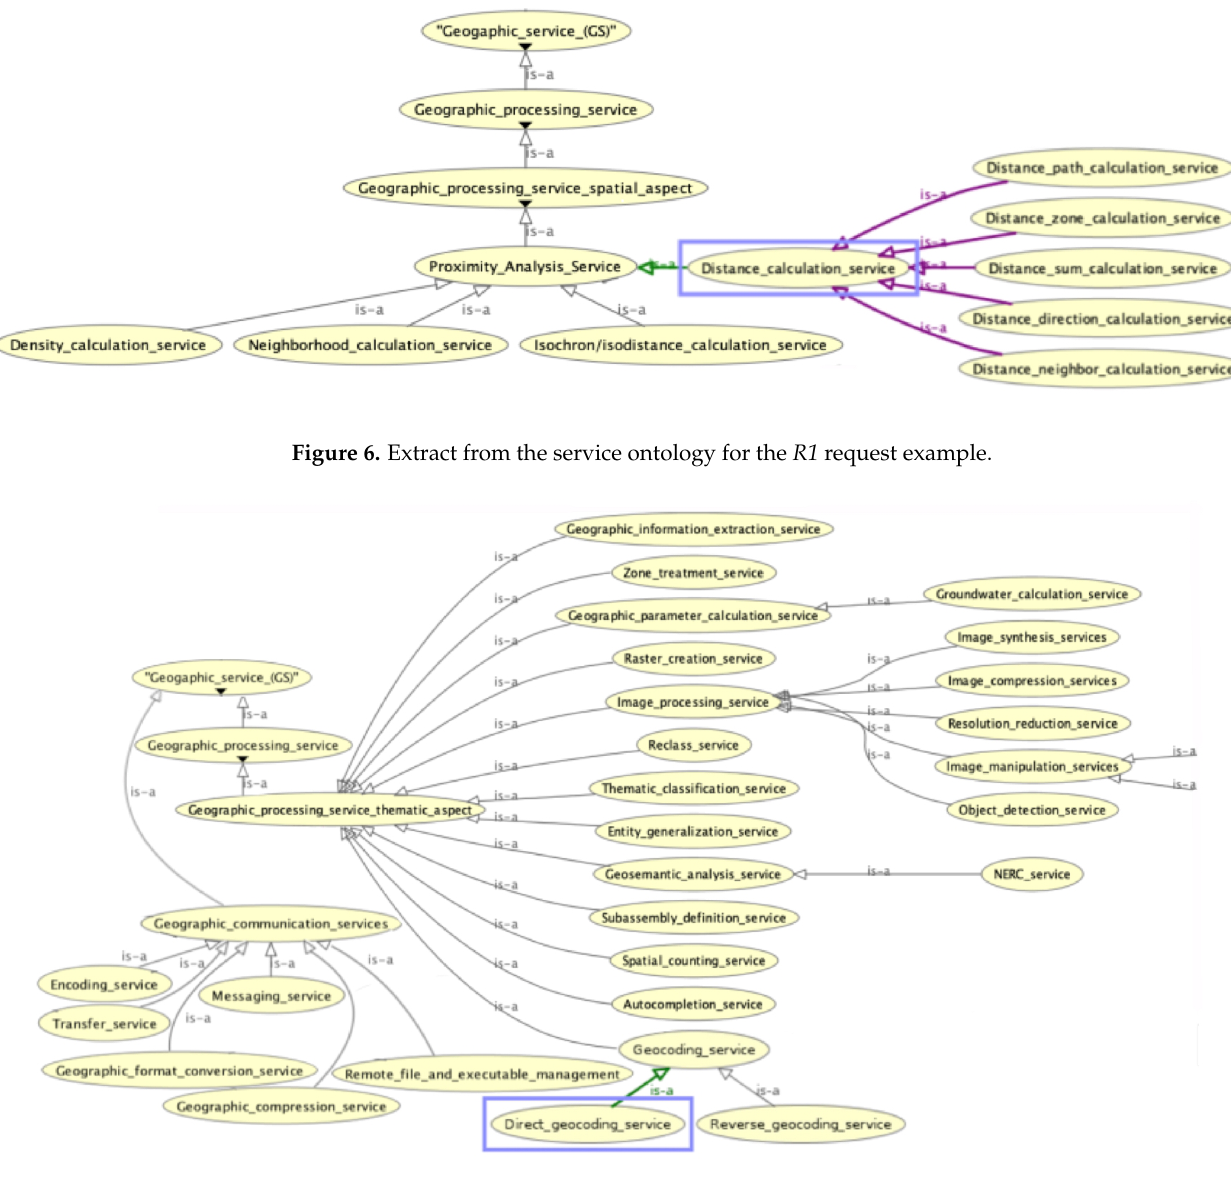
Figure 7. Extract from the service ontology for the R2 request